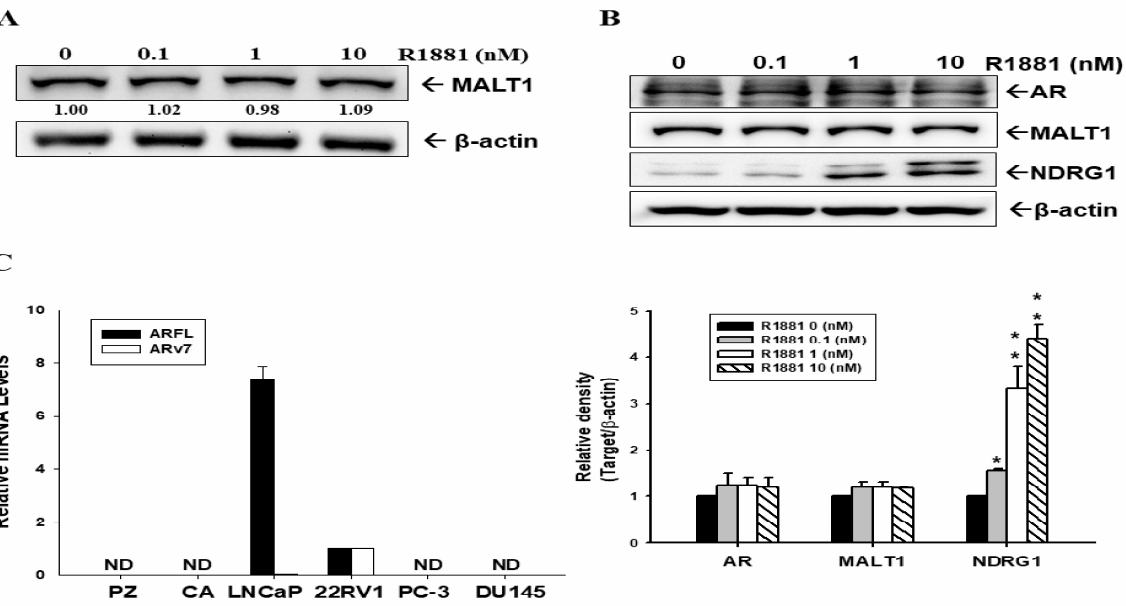
Figure 4. Androgen does not affect MALT1 expression in PC-3 cells and ectopic ARFL-overexpressed PC-3 cells. ( A ) The PC-DNA cells were treated with various concentrations of R1881 as indicated for 24 h. The cells were lysed, and the MALT1 and β -actin expression was determined using immunoblot assays. The numbers indicate the ratio of target proteins/ β -actin in relation to vehicle-treatment. ( B ) The PC-ARFL cells were treated with various concentrations of R1881 as indicated for 24 h. The cells were lysed and analyzed for AR, MALT1, NDRG1, and β -actin using immunoblot assays (top), as above. The quantitative data were expressed as the intensity of protein bands of the target proteins/ β -actin relative to the control vehicle-treated group (bottom). ( C ) The mRNA levels of ARFL and ARv7 in the prostate cell lines, as indicated, were determined by RT-qPCR analysis (PZ: PZ-HPV-7, CA: CA-HPV-10). The mRNA levels of ARFL and ARv7 in 22Rv1 cells are regarded as 1, and ND represents non-detectable. * p < 0.05, ** p <